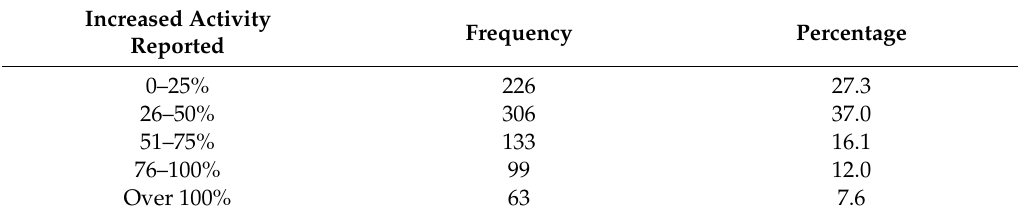
Table 4. The amount of increased physical activity reported by trail users (since starting trail use, reported by trail users).